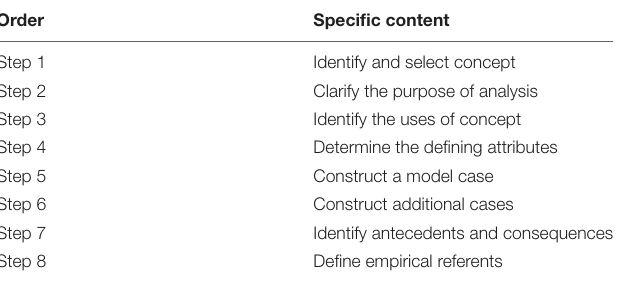
TABLE 1 | Eight steps for concept analysis as interpreted from Walker and